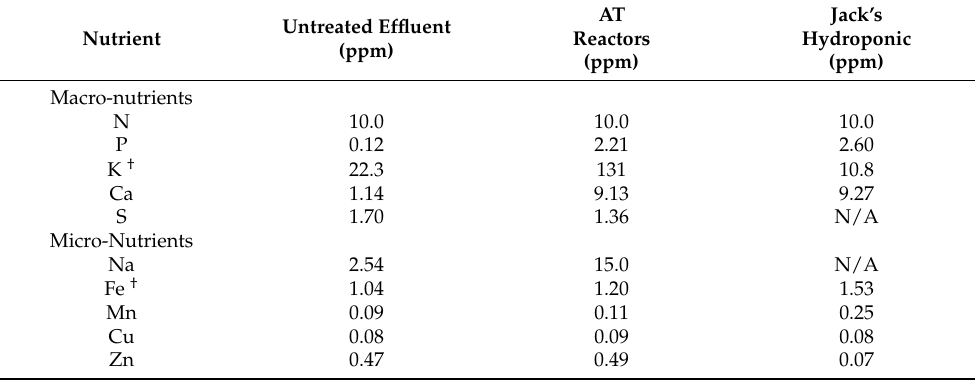
Table 6. Hydroponic solution ratio comparison. The plant available nutrient ratios of the untreated KFRAG effluent, the KFRAG effluent after AT, and a commercial hydroponic fertilizing solution on a ppm basis is shown. All nutrients are compared to N. Macro-nutrients (and Na) are normalized to 10 ppm and micro-nutrients are normalized to 100